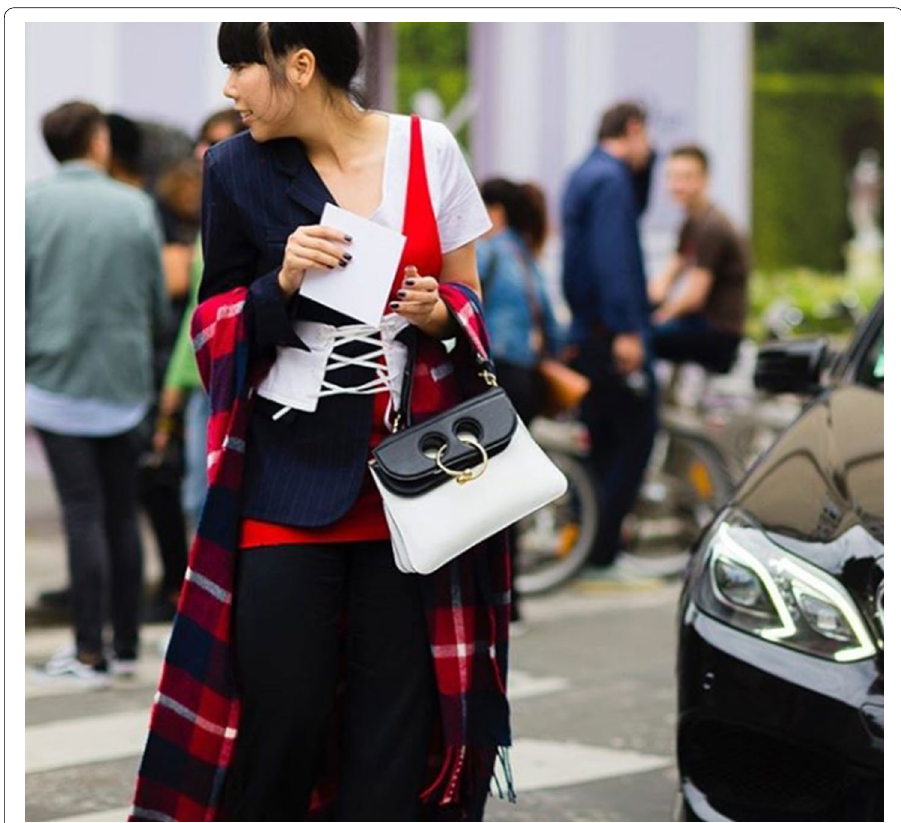
Fig. 19 Going for 4th July colours or anticipating Bastille Day. https ://www.insta gram.com/p/BHeyu N7jXY J/. Accessed 5 October